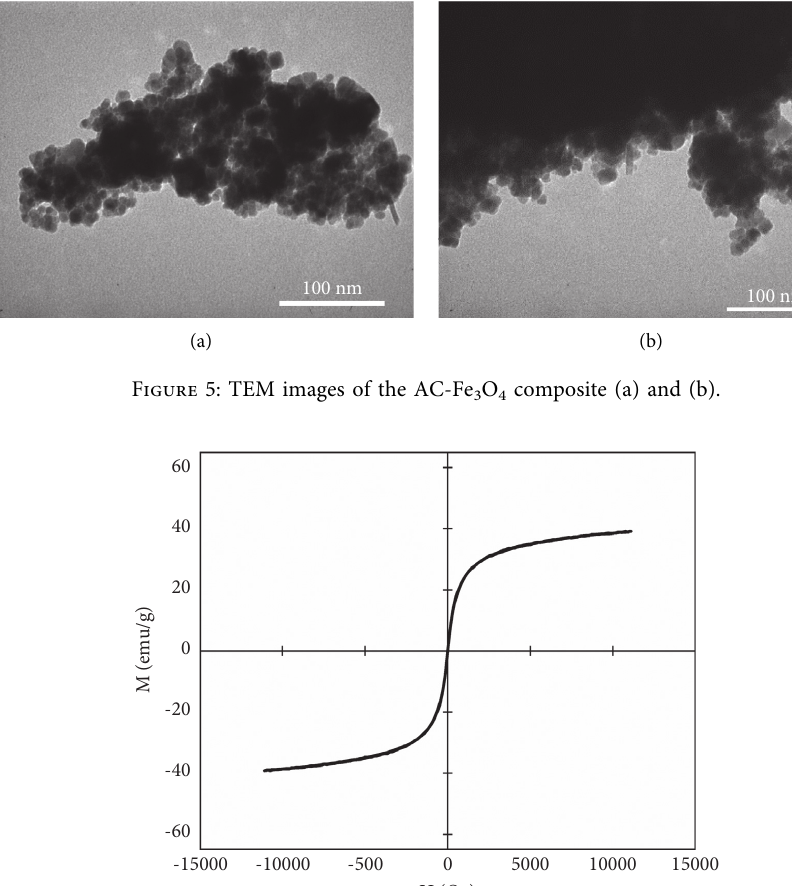
Figure 6: Magnetization hysteresis curve of the AC/Fe